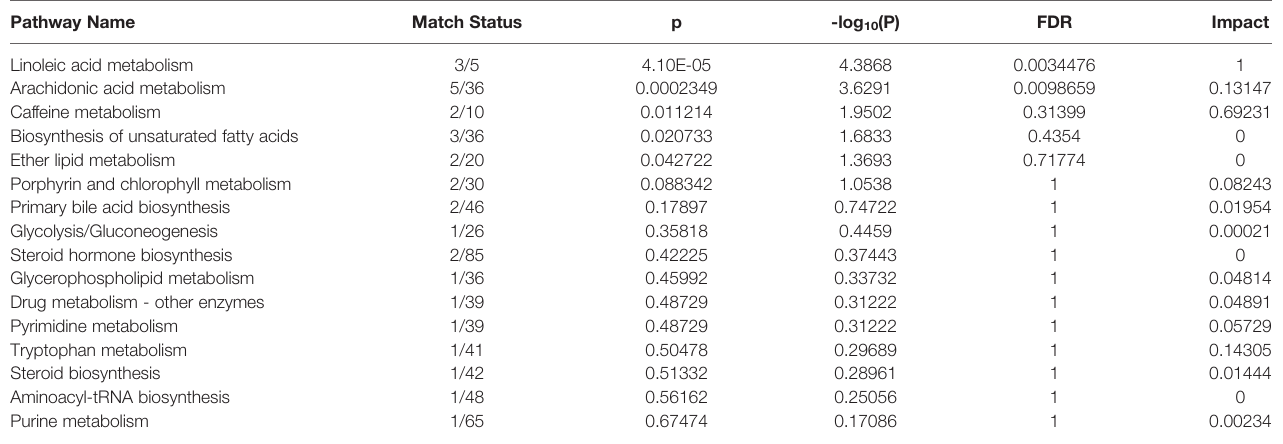
TABLE 3 | The results from metabolic pathways of distinct